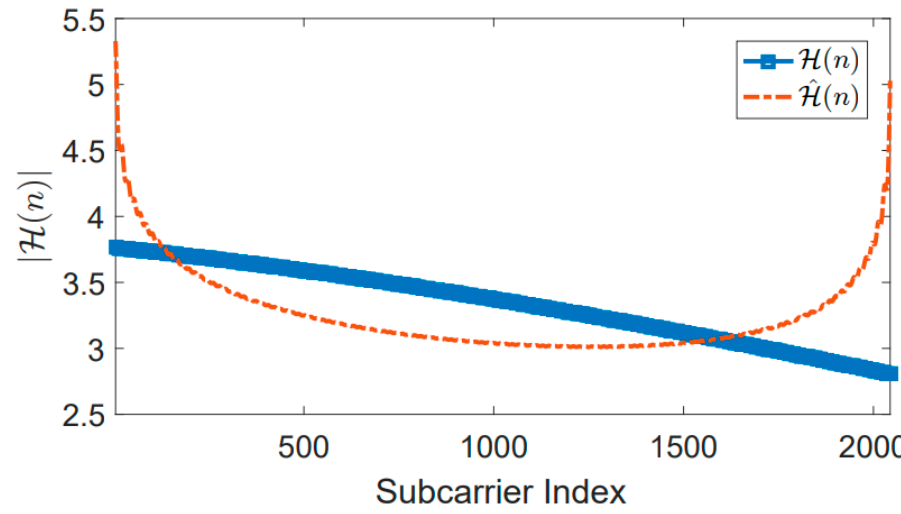
Figure 8. Example of MLE channel estimate using the receiver’s beam squint. There is no beam squint in the transmitter and only one path. No more noise exists. The number of antennas N = 16 [41].